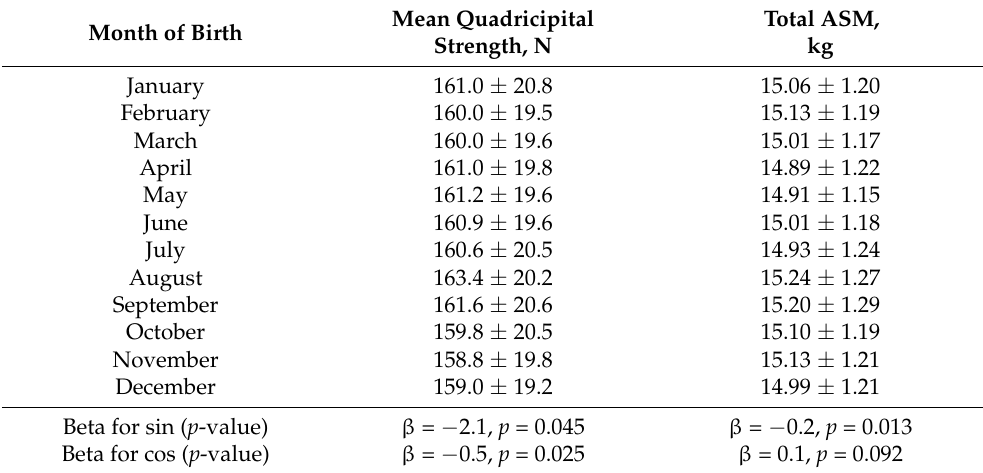
Mean Quadricipital Strength, N